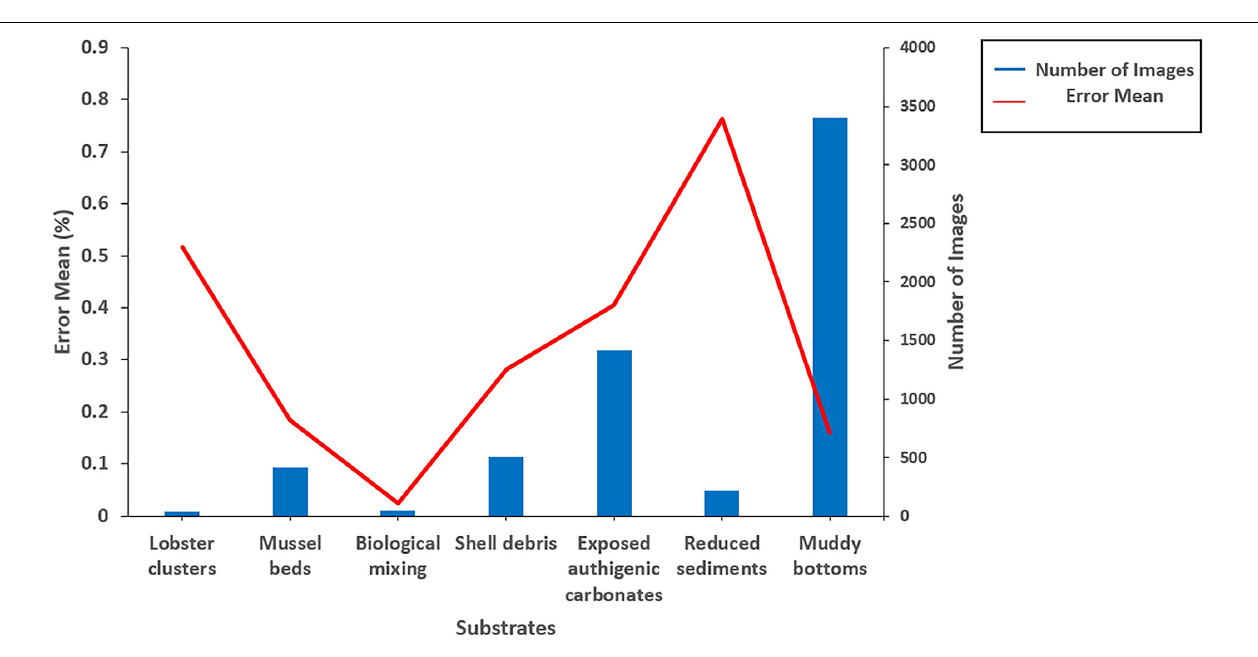
epifauna over other existing methods ( Table 2